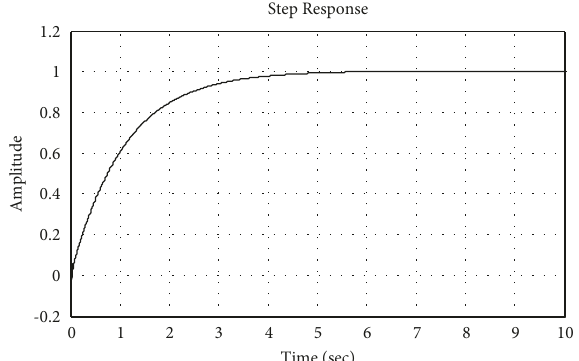
Figure 7: Step response curve of the system after quadratic optimal control.